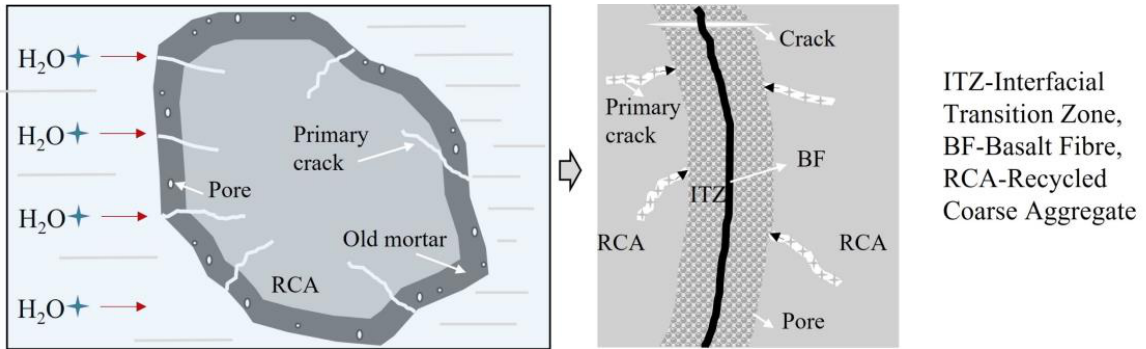
Figure 5. Schematic Diagram of RCA ’s “ Reservoir Effect ” .